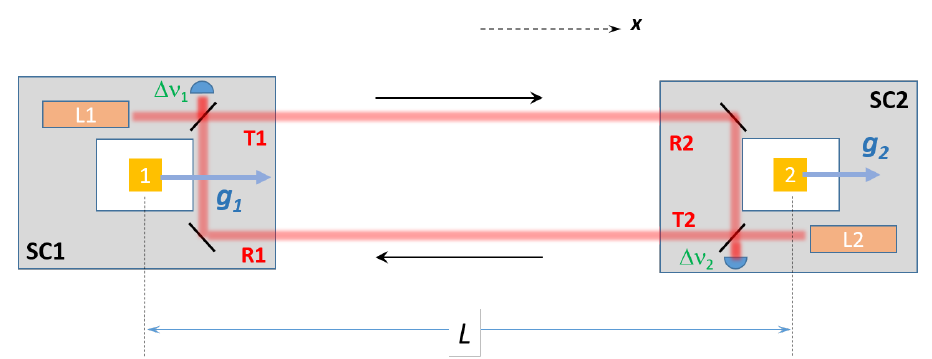
Figure A1. Cartoon of interspacecraft geodesy measurement configuration, including interspacecraft exchange of laser light, interferometric beatnote detection, and geodesic reference